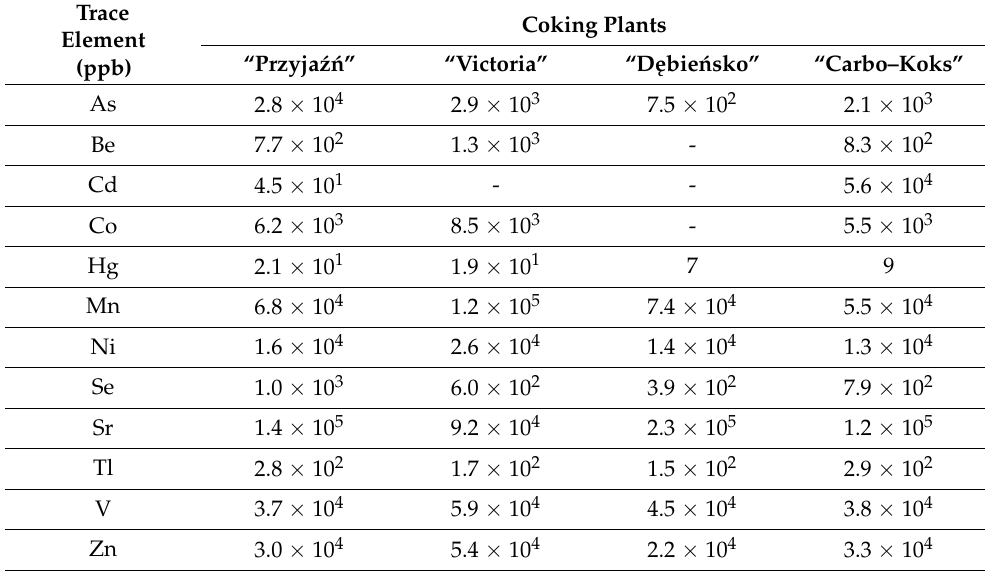
Table 6. Levels of selected trace elements in coke